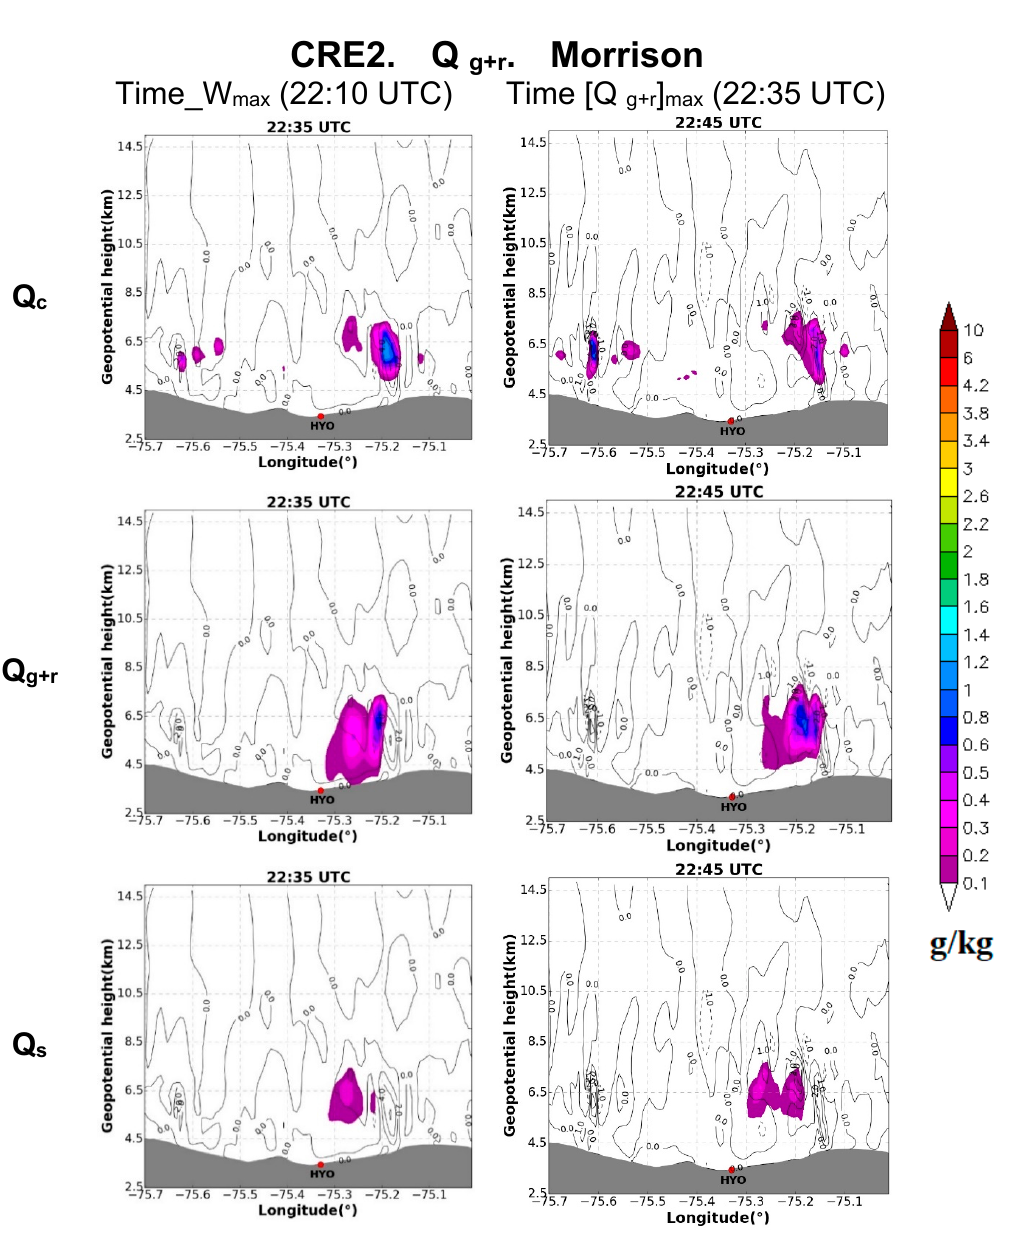
Figure 19. Vertical distribution of vertical wind velocity and mixing ratios of hydrometeors, Q c , Q g+r , and Q s , at two maximum development moments: the time of maximum mixing ratio of graupel + rain water, Q g+r (right), and the time of maximum vertical velocity, W (left). Latitudinal cross section at approximately 12° S latitude, crossing HYO between 5.65 and 75.2° W. WRF output for CRE2 using the Morrison scheme.